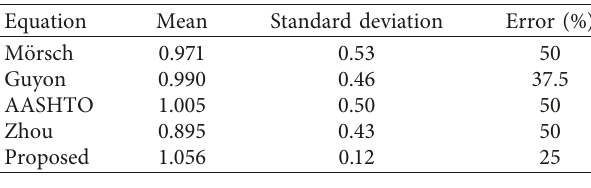
Table 4: Evaluation of the bursting force equations’ accuracy.